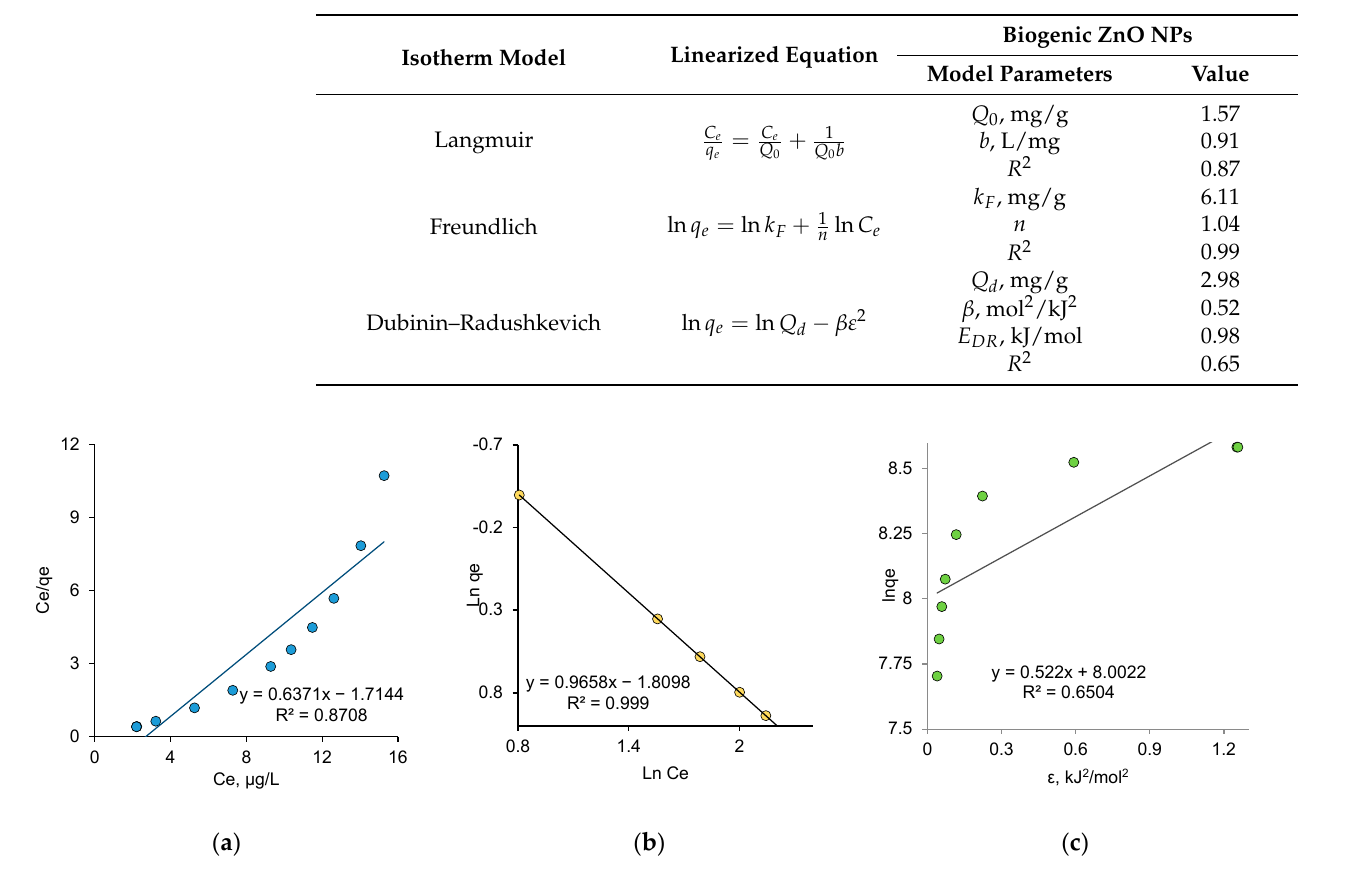
Table 4. Parameters calculated from various isotherm models (initial AY concentration: 20 mg/L, adsorbent dose: 50 mg, pH: 7.0).